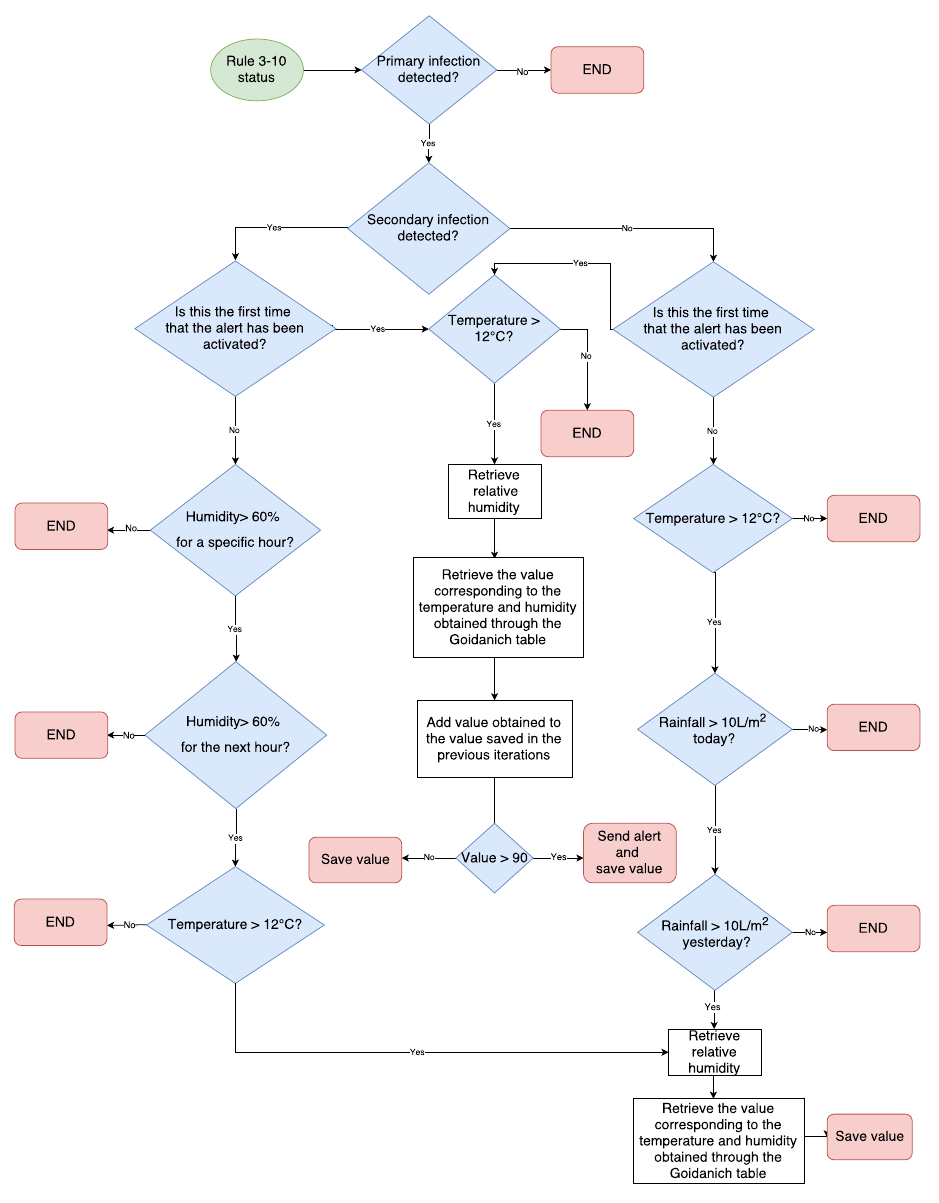
Figure 1. Flow diagram of the Rule 3-10